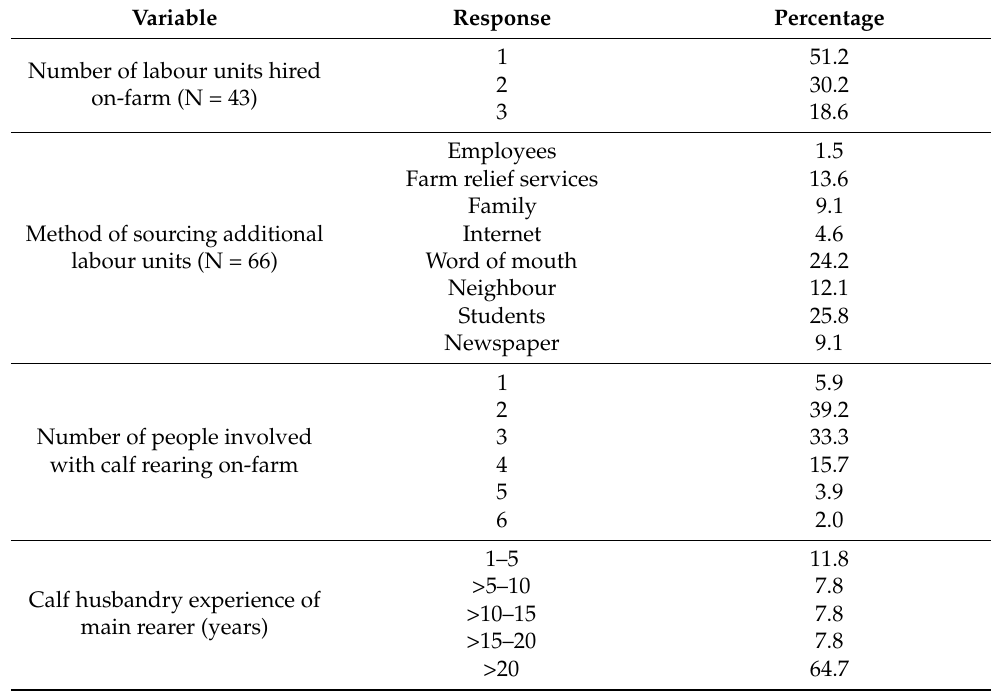
Table 4. Labour unit related information for the surveyed farms (N = 51 unless otherwise